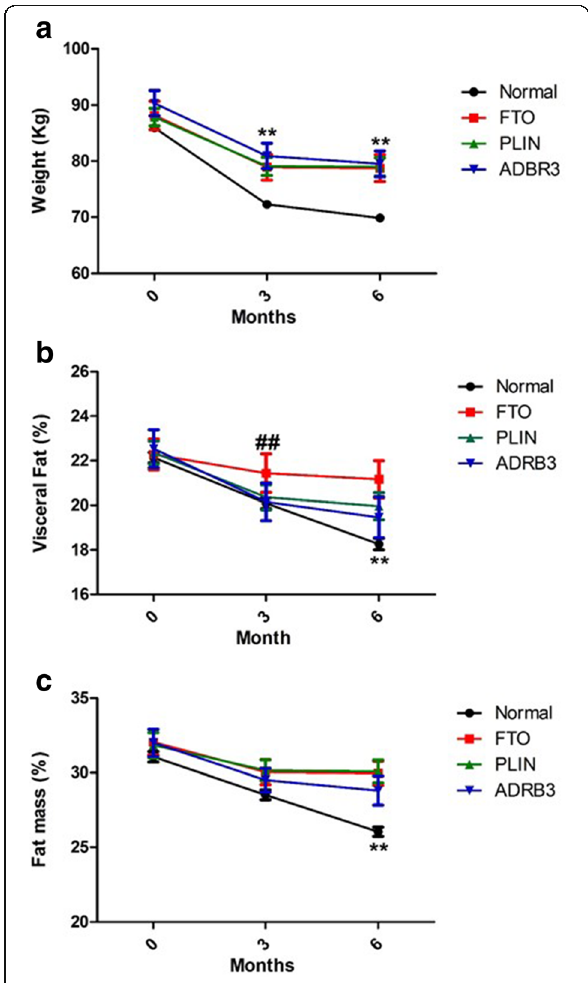
Fig. 4 Effect of polymorphism in body composition after treatment with GC and GNN. Presence of polymorphism PLIN4 (11482G > a ), FTO (rs9939609 A/T), and ADRB3 (Trp64Arg) attenuated response to GC and GNN treatment on weight ( a ), Visceral Fat ( b ) and Fat mass ( c ). ** p < 0.05 vs all polymorphism presence. ## p < 0.05 FTO vs normal. PLIN: 11482G > A, FTO: rs9939609 A/T and ADRB3: Trp64Arg